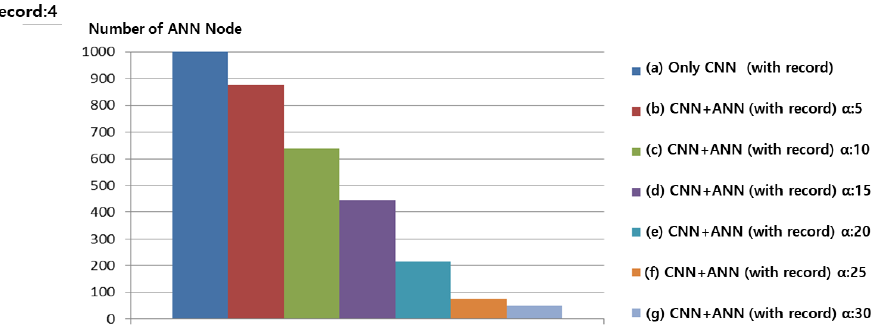
Figure 10. Number of ANN Nodes when Record was four.